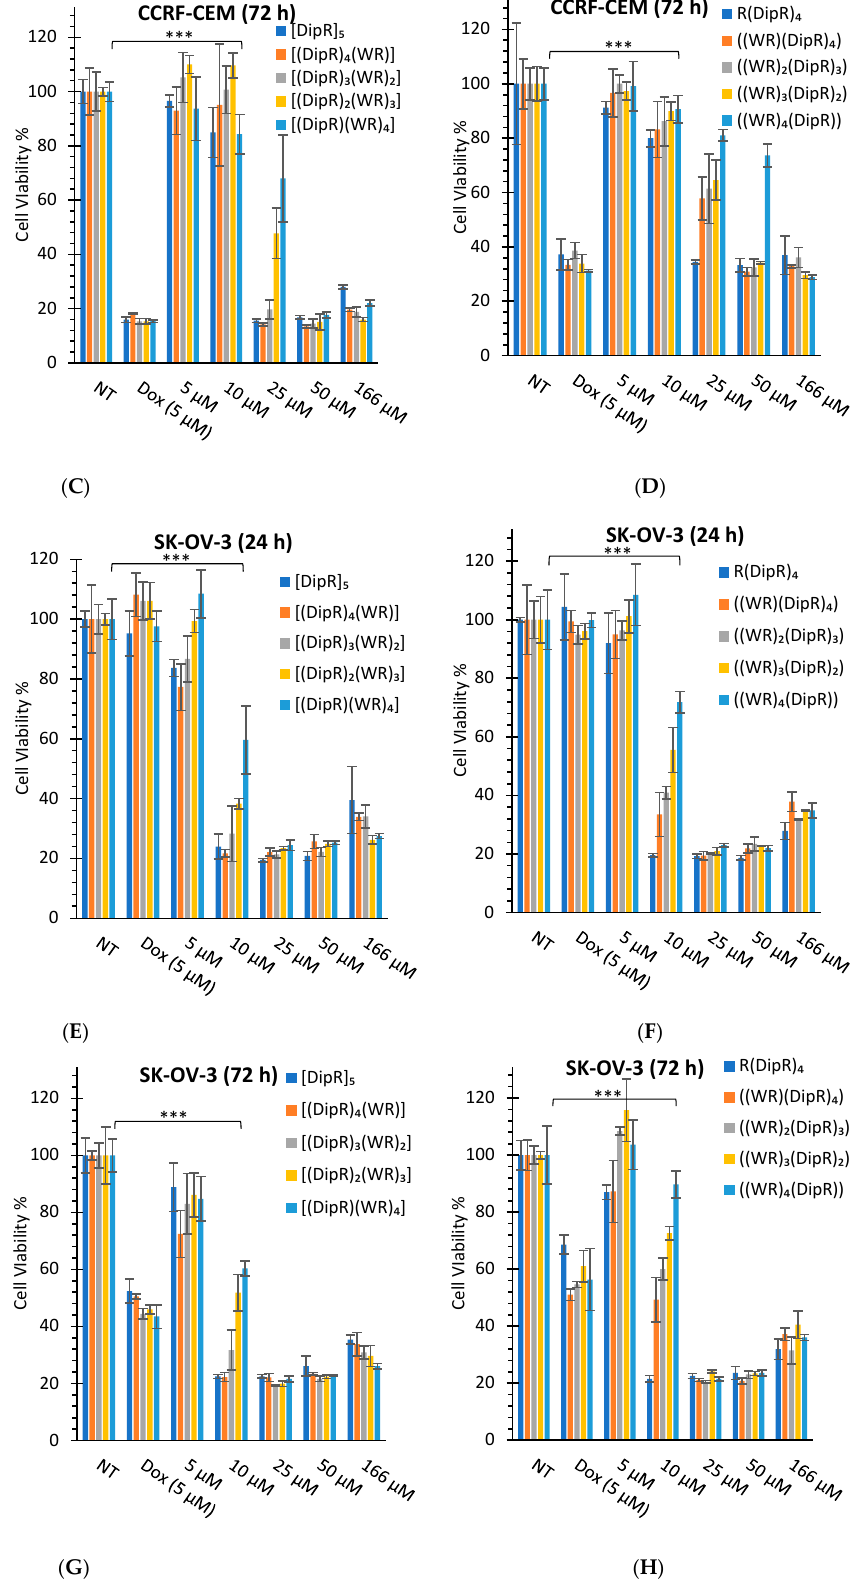
Figure 3. Cytotoxicity study of cyclic ( A , C , E , G ) and linear ( B , D , F , H ) peptides in CCRF-CEM cells and SK-OV-3 after 24 h and 72 h incubation. Results are mean ± SD (n = 3) (*** p < 0.001 treatment vs. no treatment (NT)).